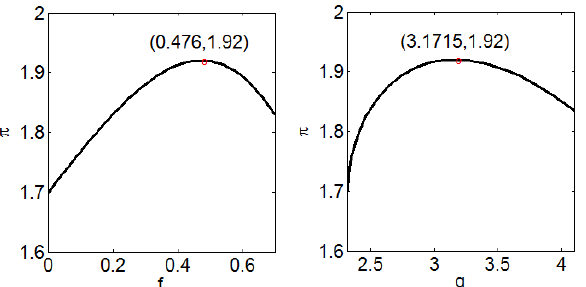
Figure 5. Changes in the brand’s profit with f and q when β o = β s = 0.4. Figure 5 indicates that when